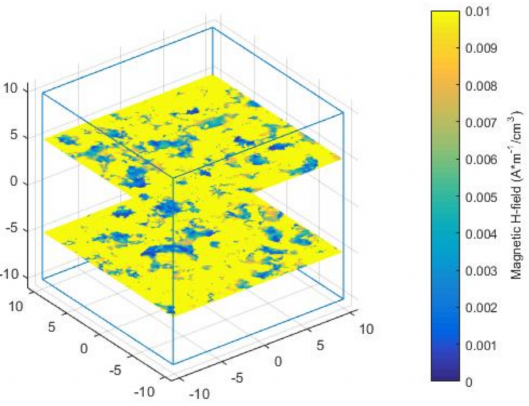
Figure 6. Chromatogram of the magnetic H-field when the volume fraction of ferrite grains is